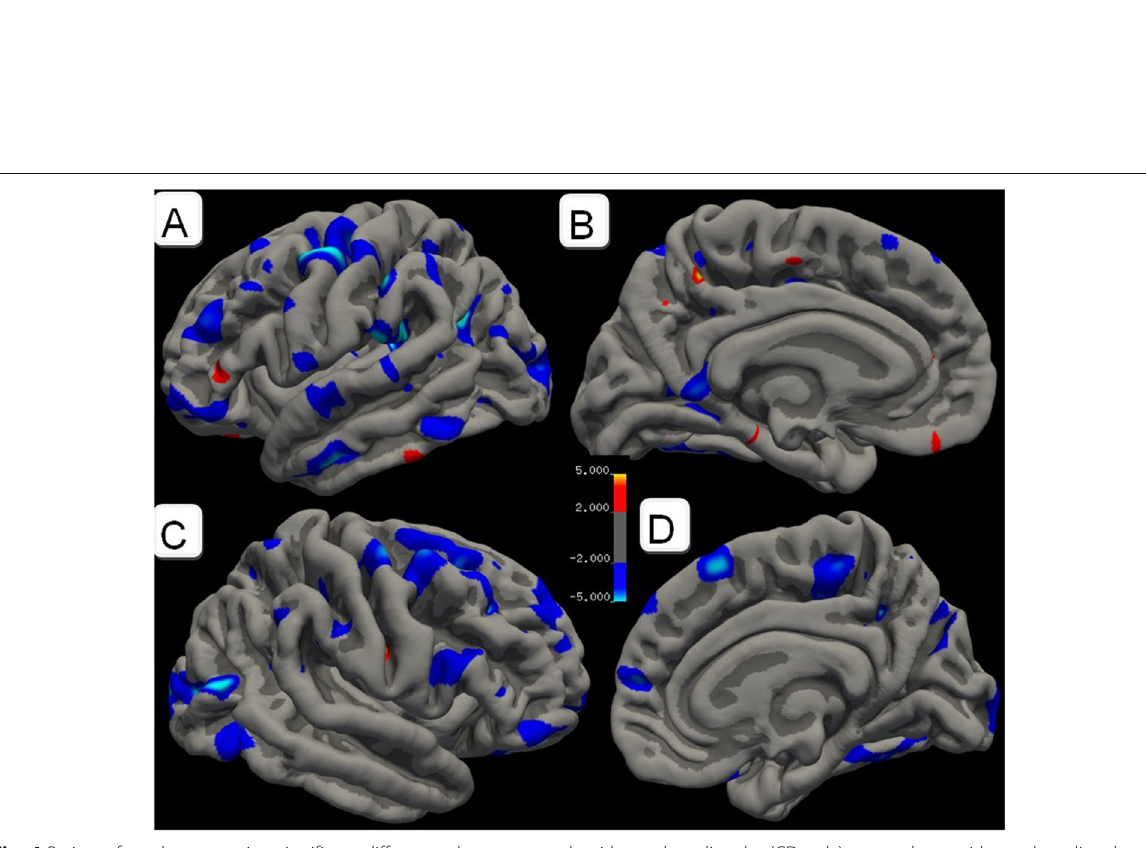
Fig. 3 Brain surface demonstrating significant differences between youth with conduct disorder comorbid with attention deficit-hyperactivity disorder (CD + ADHD) versus healthy control youth. a Left lateral. b Left medial. c Right lateral. d Right medial